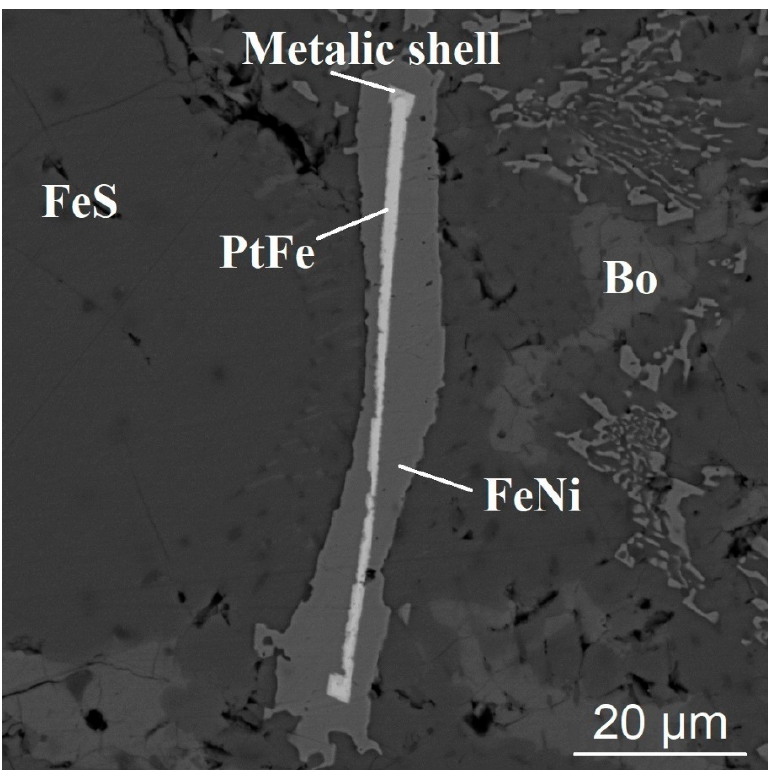
Figure 3. Needle formations of the PtFe intermetallic compound in a double shell in a copper–nickel matte. Matte is obtained after melting a copper–nickel sulfide ore at a temperature of 1300 ◦ C.